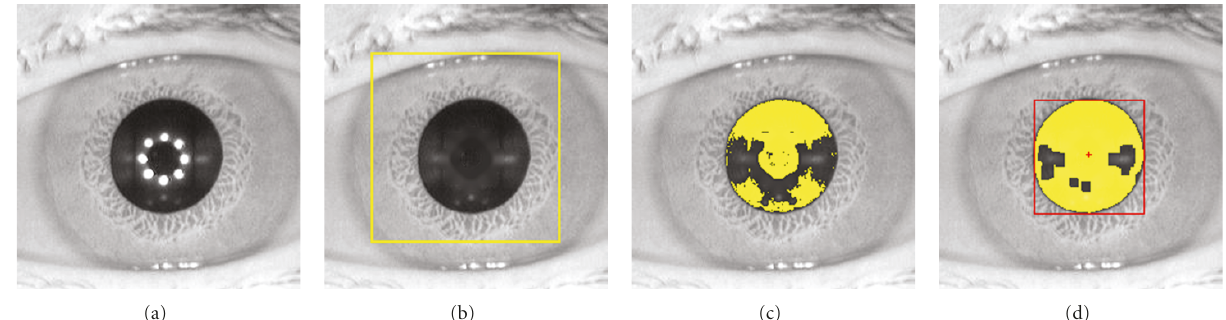
Figure 3: Rough localization of the pupil. (a) Source image, (b) filtered image and definition of the zone of interest for the pupil detection, (c) pupil detection by thresholding means, and (d) pupil localization (bounding box and centre